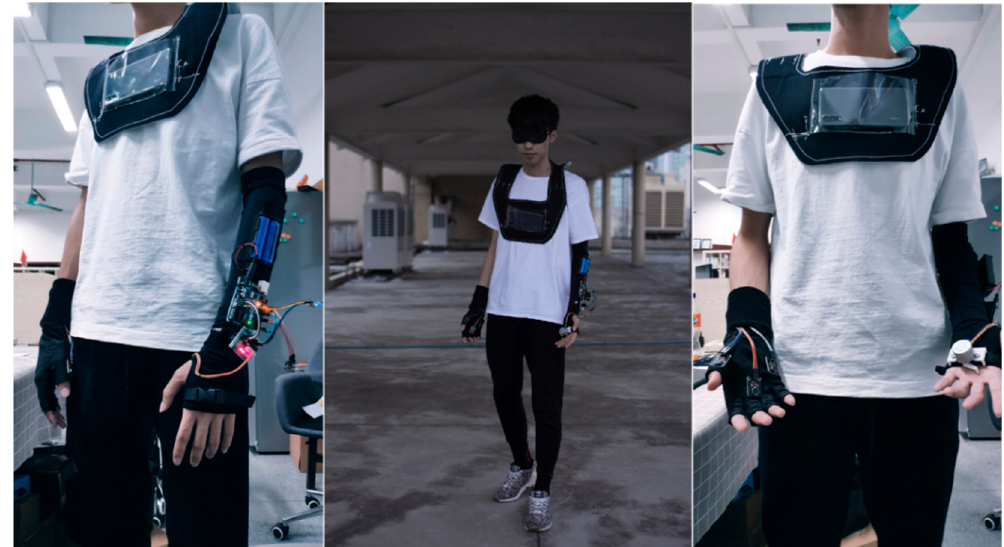
Figure 8. The implemented ANSVIP prototype with full functionality.